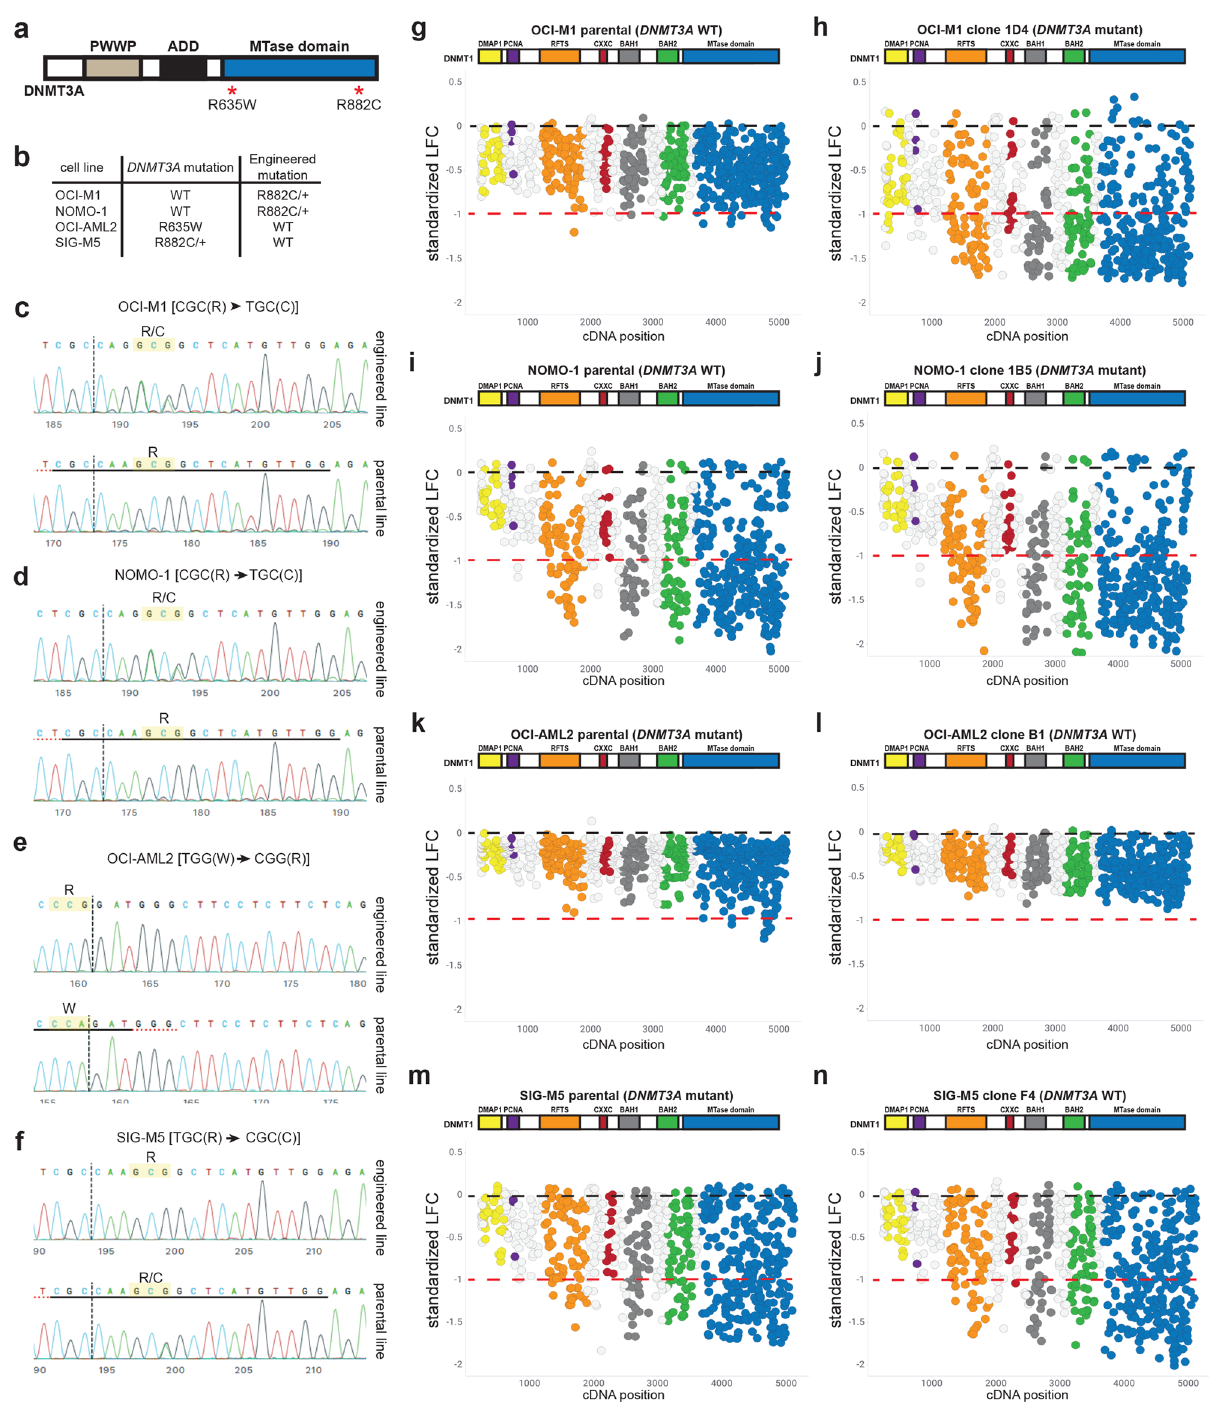
DNA methylation sites 31,32 , and can also function as an auto- inhibitory domain of DNMT1 33 . BAH domains can bind to histone domains in DNMT1 were reported to be essential for the locali- zation of DNMT1 to replication foci 34 . These domains could be considered as therapeutic approaches in lieu of the MTase